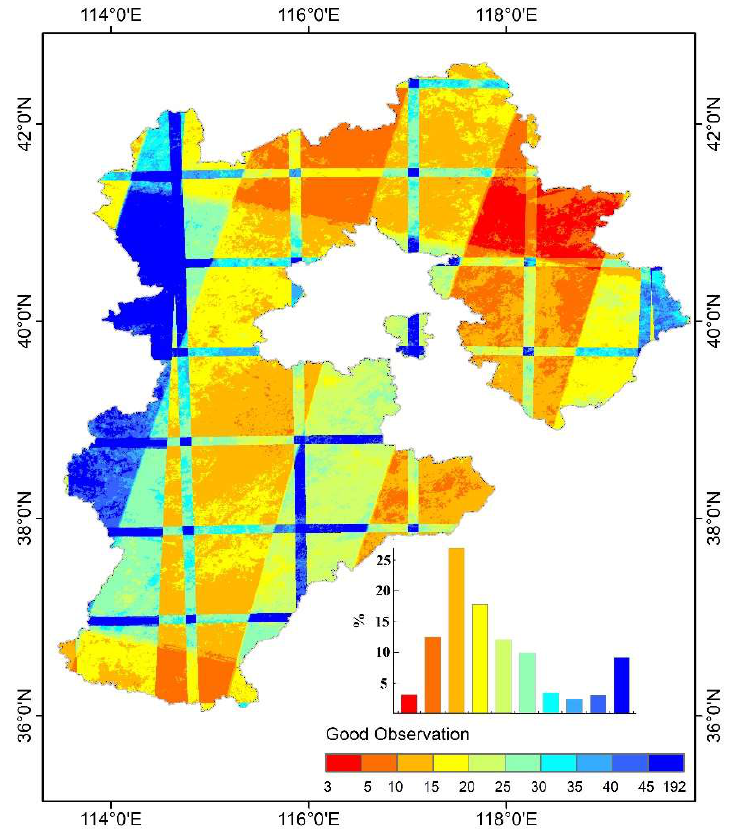
Figure 14. Number of good observations between June and October 2017 by masking opaque and cirrus clouds. The embedded histogram shows the distribution of Sentinel-2 imagery number with different color bars, and the color is the same as the map legends.